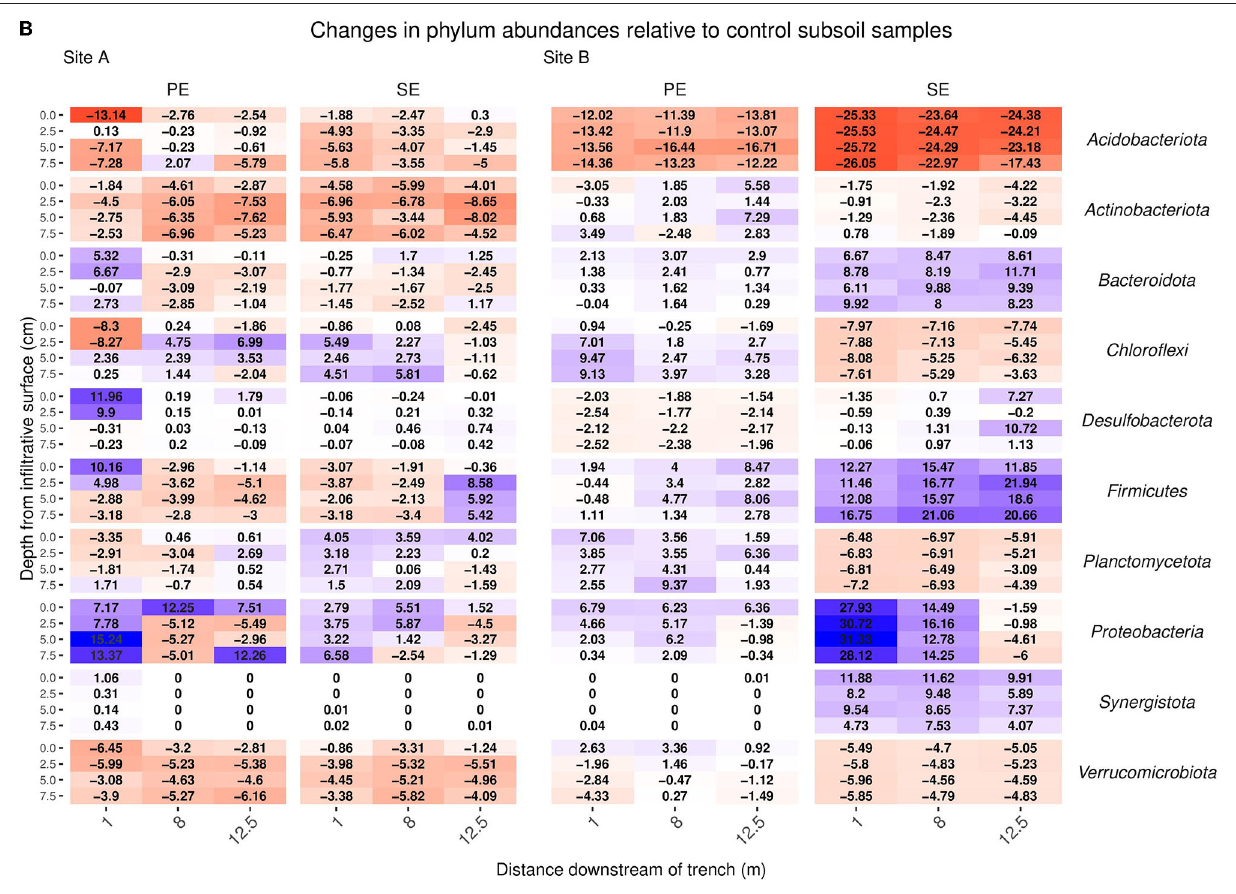
0.17, 14.62 ± 4.47, and 14.24 ± 6.46, respectively), and for Site B, Acidobacteriota, Proteobacteria, and Chloroflexi (27.35 ± 4.1, 9.77 ± 0.41, and 11.16 ± 7.77, respectively) as